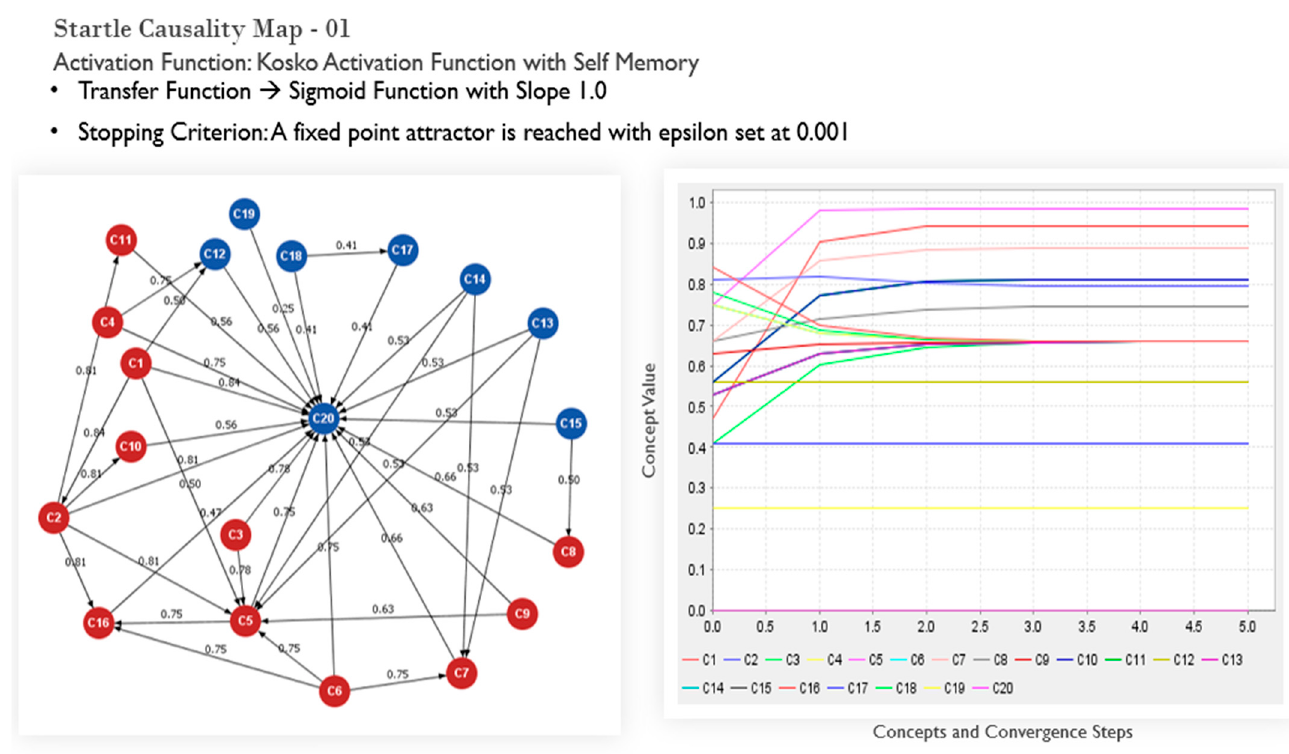
Figure 4. Initial mapping test output with associated convergence output plot: the x -axis shows the steps to convergence for a particular iteration; the y-axis shows the converged value of concepts contributing to the startle output.